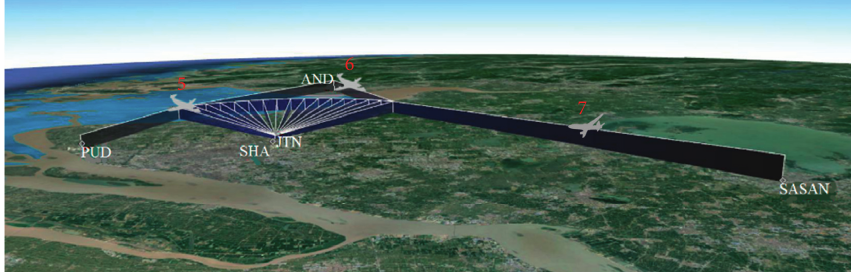
Figure 16: Aircraft arriving from different